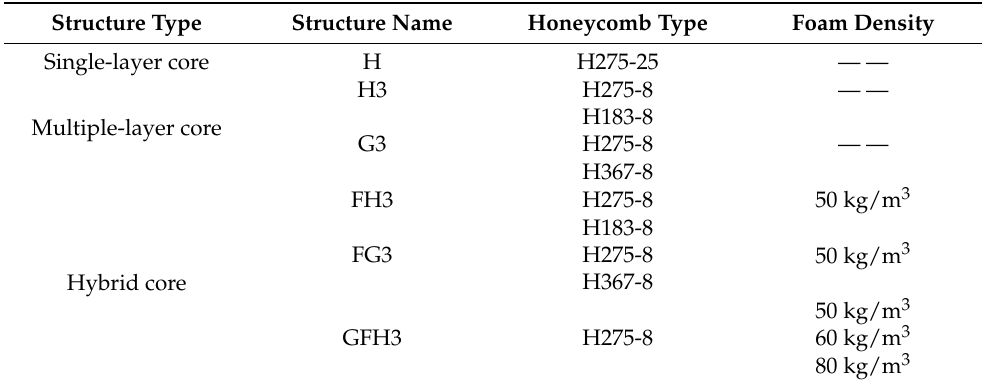
Table 3. Types of core